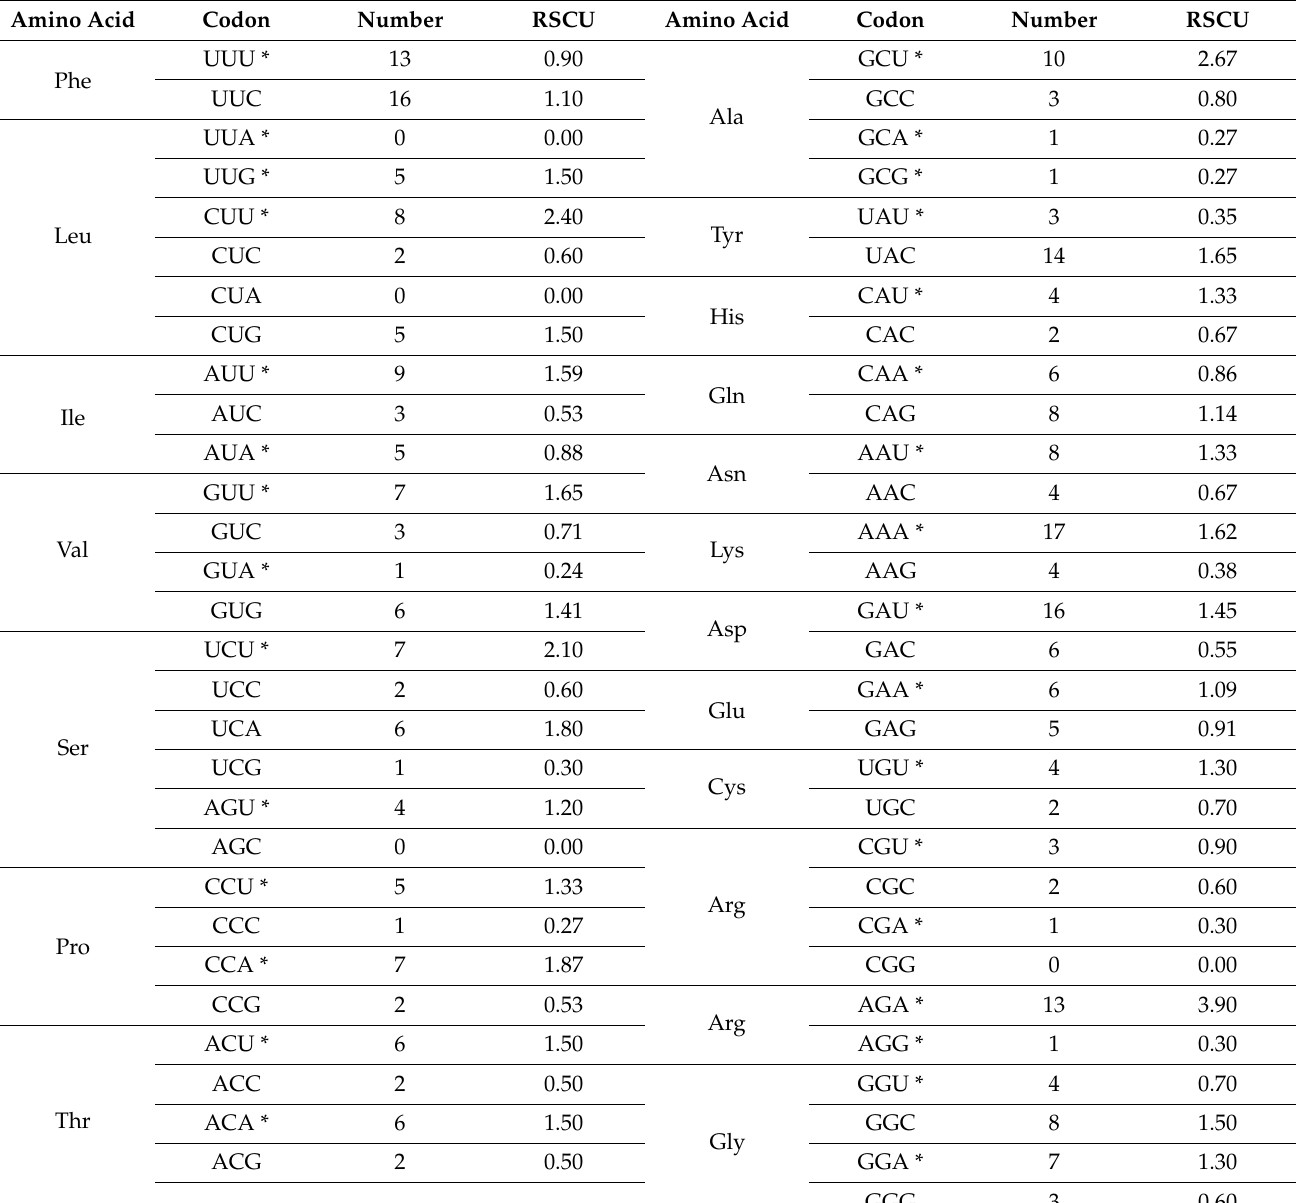
Table 3. Relative synonymous codon usage values and number of codons for CitXET genes (300